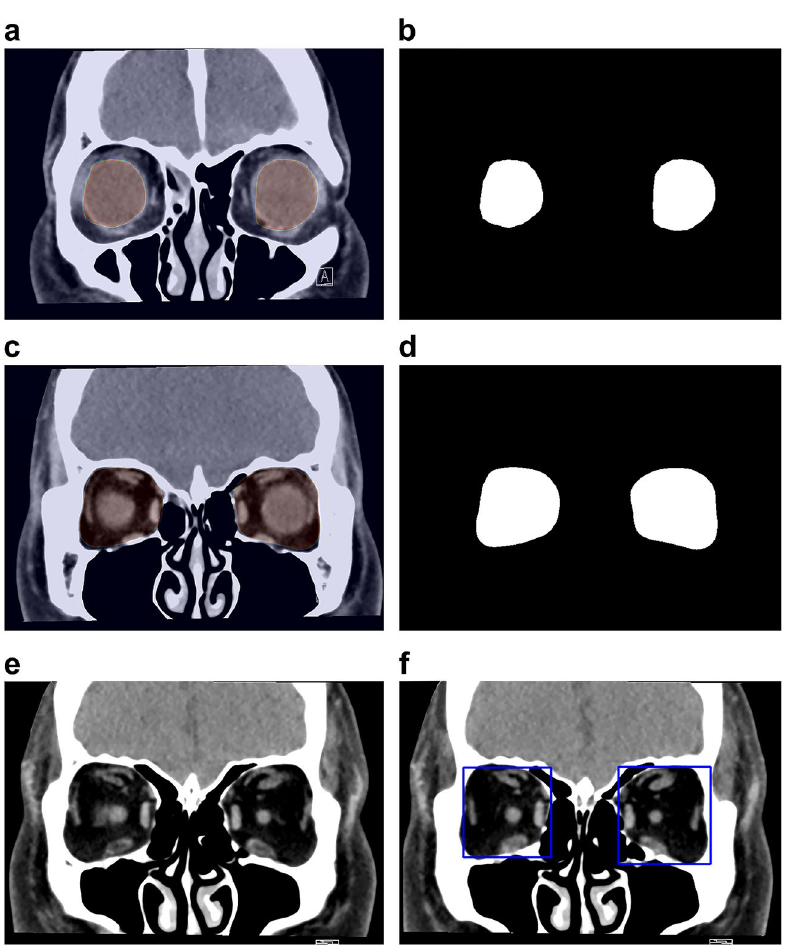
Figure 4. The coronal slice ( a ) and the result ( b ) used for the segmentation of the eyeball. The coronal slice ( c ) and the result ( d ) were used for the orbit segmentation. The coronal slice ( e ) and region of interest (the area inside the blue squares) ( f ) used when Residual Network-50 recognized the retrobulbar region from ( b ) and ( d